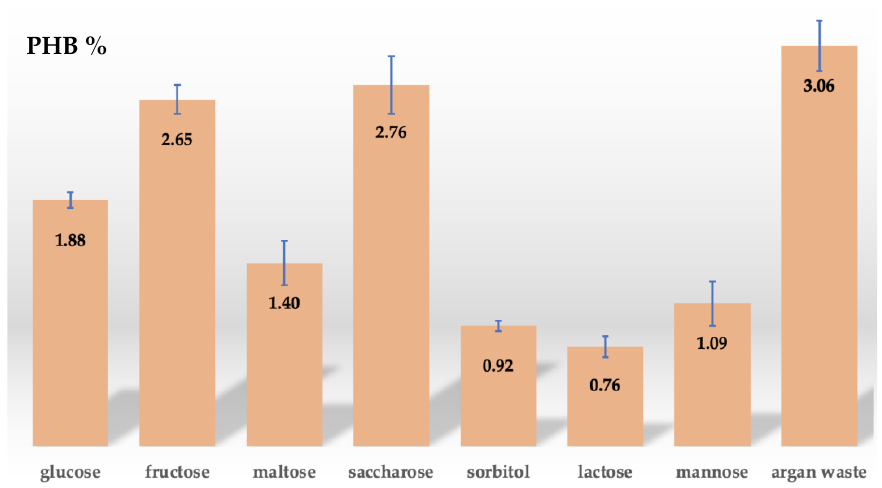
Figure 4. Bio-based polymer final yield extracted from 50 mL 1B culture with 1% of different carbon sources and pretreated argan seeds pulp.